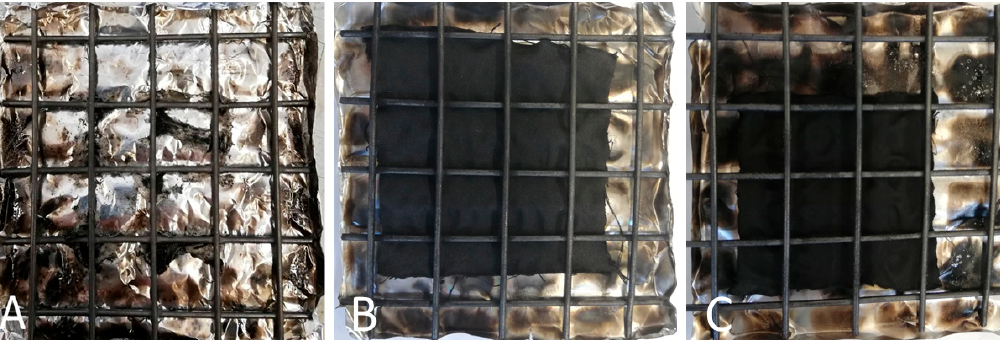
Figure 13. Residues of COT (A), COT+PA+BC(8) (B) and COT+PA+BC(8)W (C) after cone calorimetry tests (heat flux of 35 kW/m 2 ).